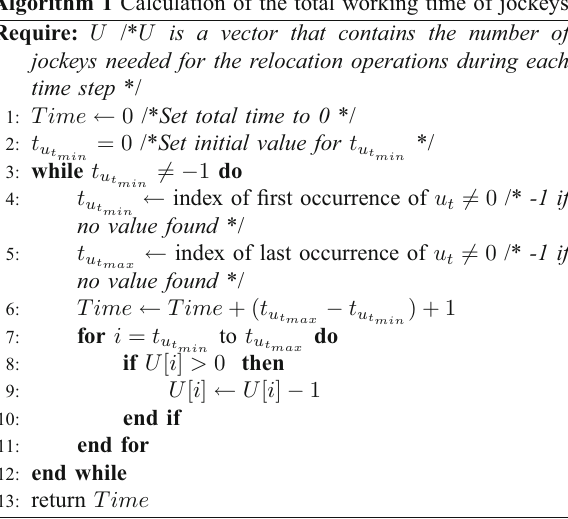
Algorithm 1 Calculation of the total working time of